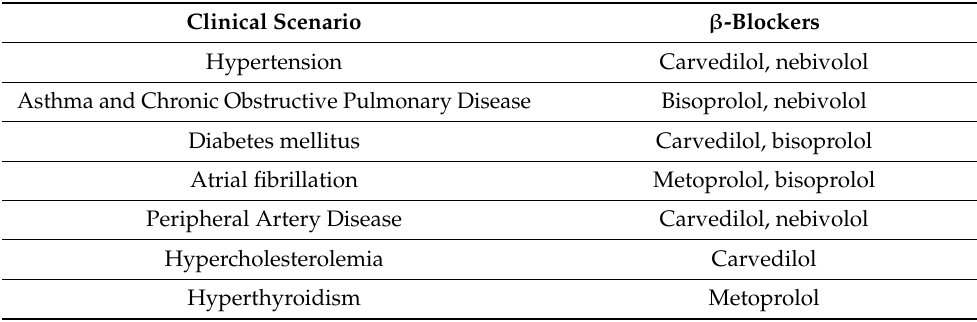
Table 3. Choice of β -blockers according to clinical